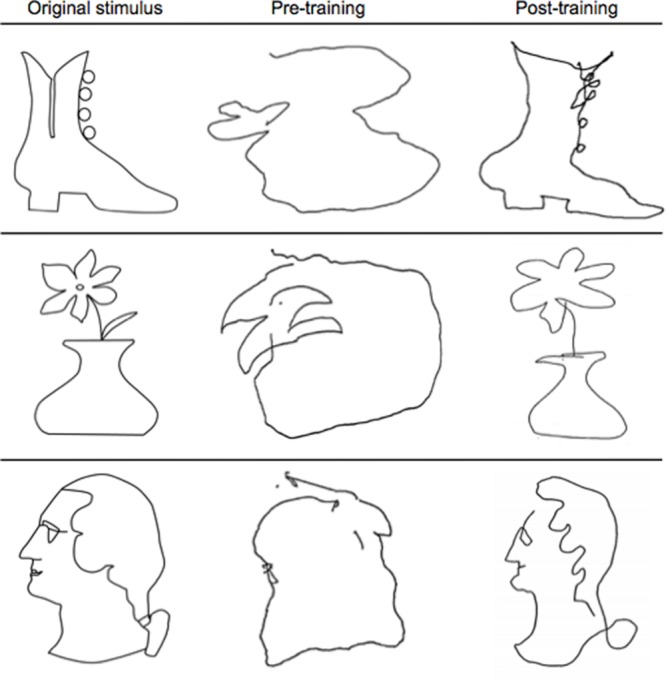
Representative examples of pre- and post-training drawings. Note the substantial improvement from pre-training (middle column) to post-training (last column) in resembling the original stimulus (first column) after just 5 days of the Cognitive-Kinesthetic training.